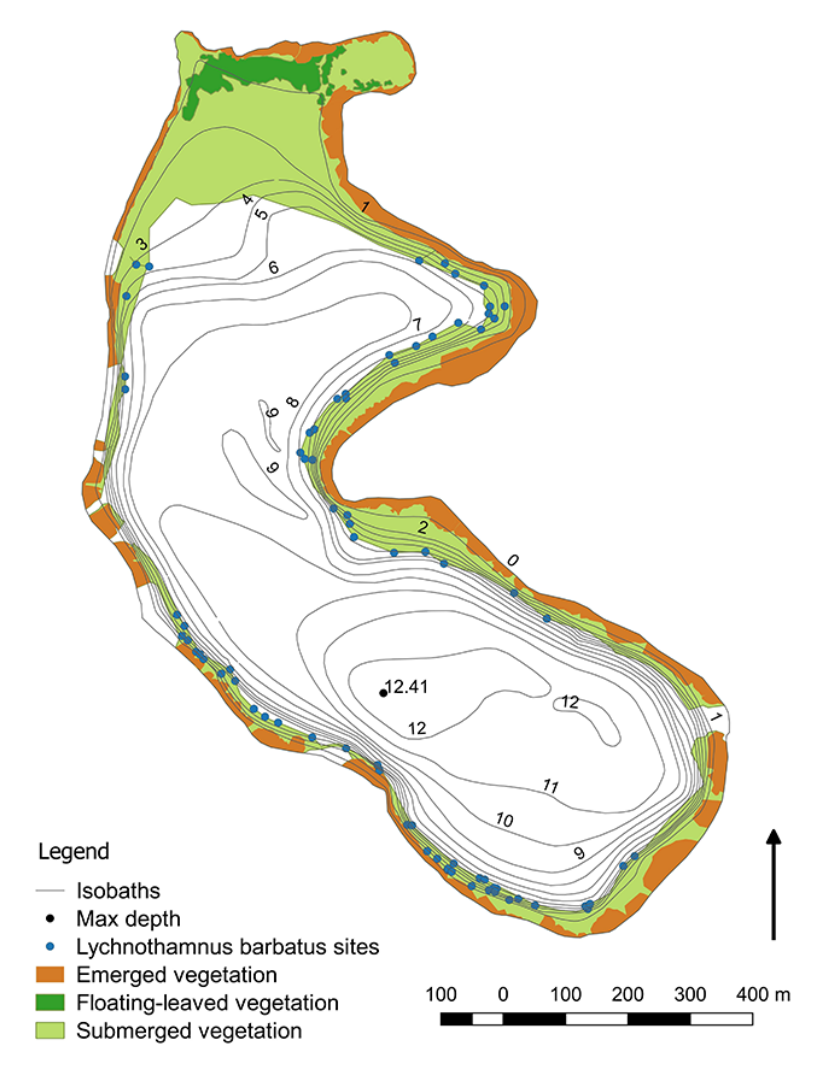
Figure 2 e current distribution of aquatic vegetation in Lake